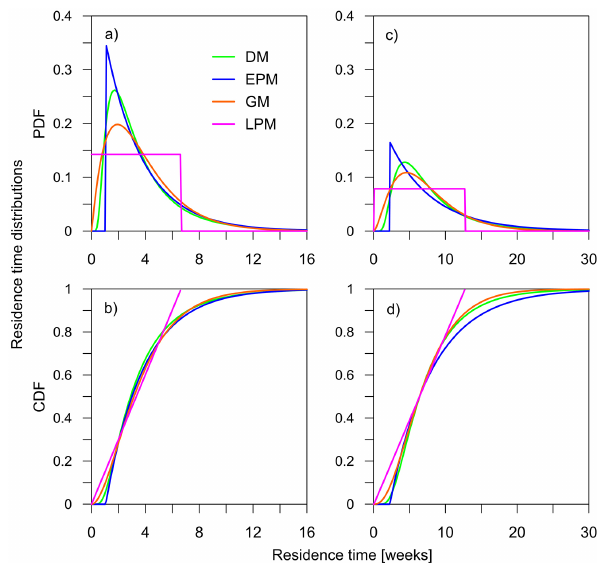
Fig. 8. Comparative characteristic shapes of residence time distri- bution functions corresponding to the best NSE using four lumped- parameter models (DM, EPM, GM and LPM): (a) and (b) for the soil site C2 located in a pasture land cover; (c) and (d) for the soil site E2 located in a forest land